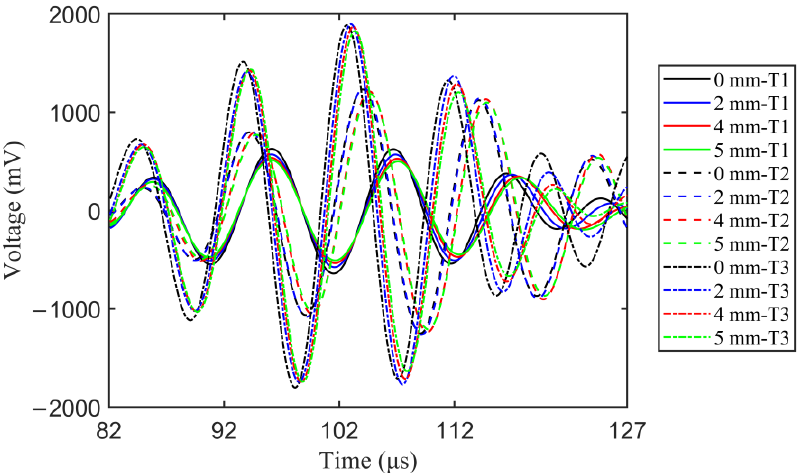
Figure 10. Experimental Lamb wave response signals of different crack lengths for specimens T1–T3.